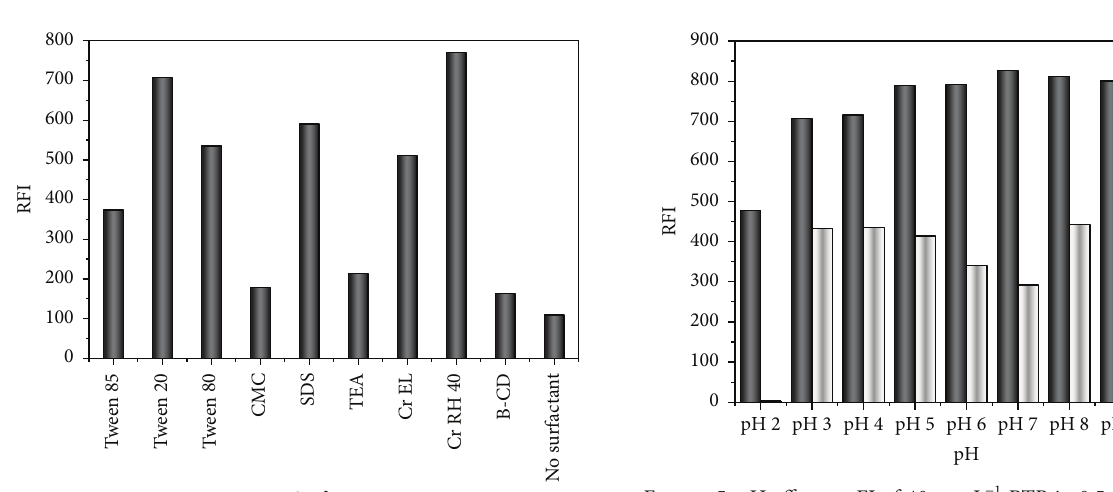
Figure 5: pH effect on FI of 40ngmL −1 PTB in 0.5 mL 1%, w/v Cr RH 40 in acetonitrile (black column in presence of Cr RH 40 and white column in absence of Cr RH 40).